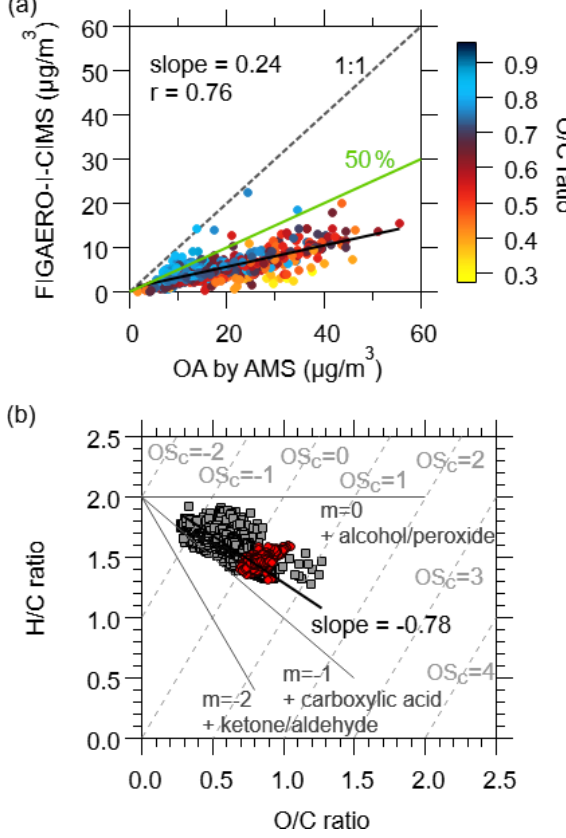
Figure 16. (a) Comparison of particulate organic compounds mea- sured by the FIGAERO-I-CIMS and AMS, color-coded by O / C ra- tios measured by AMS. The black line is the slope which represents the fraction of OA explained by the measurements of FIGAERO- I-CIMS. The green line shows the results from previous work which were ∼ 50% (Lopez-Hilfiker et al., 2016; Stark et al., 2017). (b) Van Krevelen diagrams for organic aerosol derived from AMS data (gray squares) and FIGAERO-I-CIMS data (red circles). The black line is the slope of AMS data. The gray dotted lines are esti- mated carbon oxidation